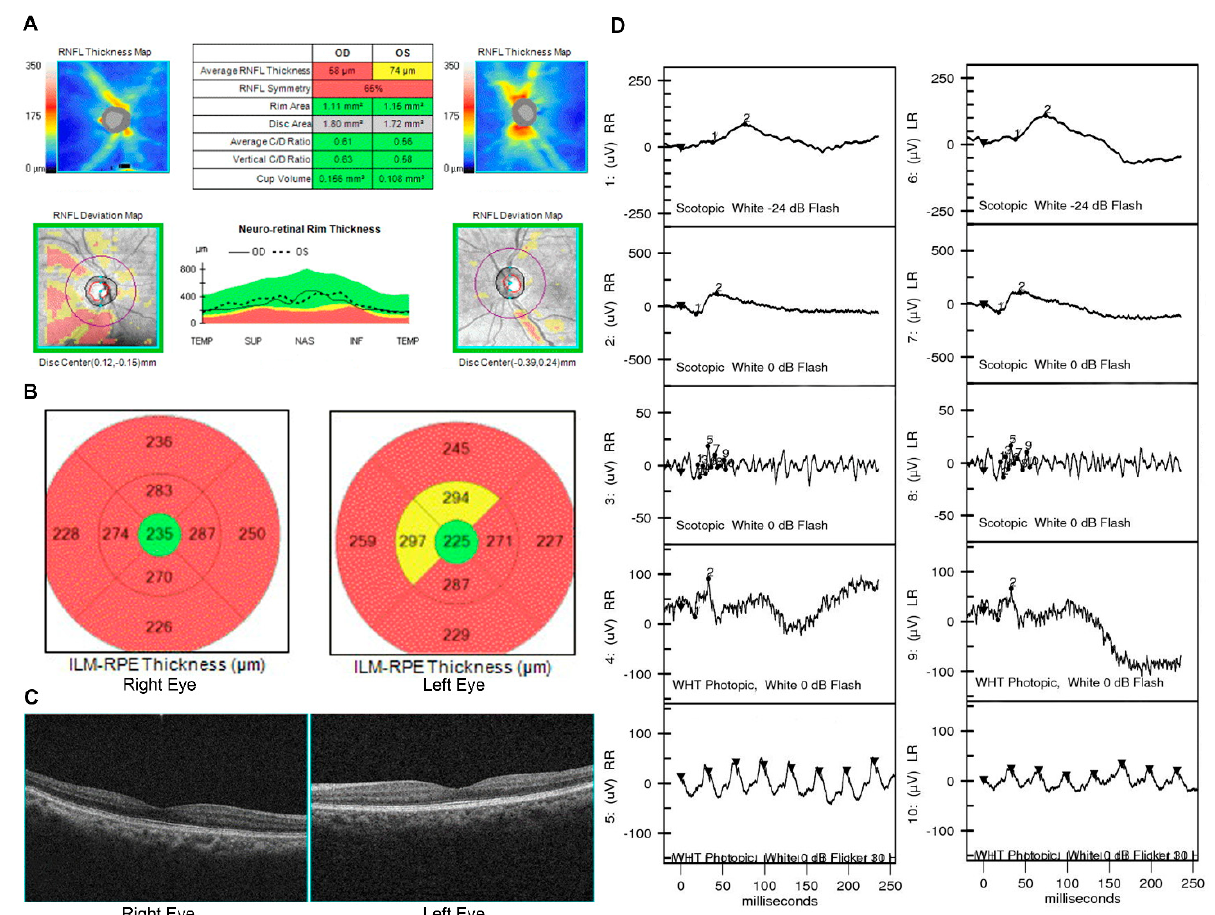
Figure 7. Multimodal images of a 67-year-old female patient diagnosed with advanced glaucoma and optic nerve atrophy. ( A ) OCT revealed enlarged optic cupping and a severely decreased retinal nerve fiber layer (58 μ m in right eye and 74 μ m in left eye), corresponding to the diagnosis of glaucoma and optic atrophy. ( B , C ) Moreover, a decrease in central macular thickness was also found in OCT, which raised the speculation of retrograde degeneration. ( D ) ffERG revealed an abnormal response in all three components, which further supported the proposal of retrograde degeneration.